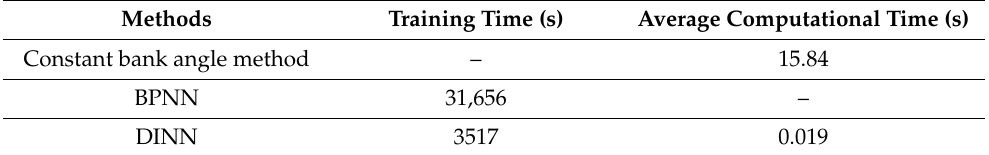
Table 6. Comparison of each method.